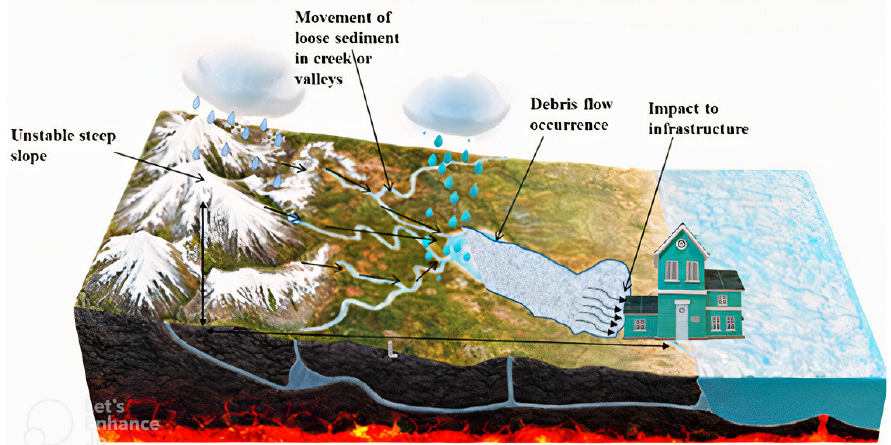
Figure 1. Illustration of debris flow process and impact on infrastructure.